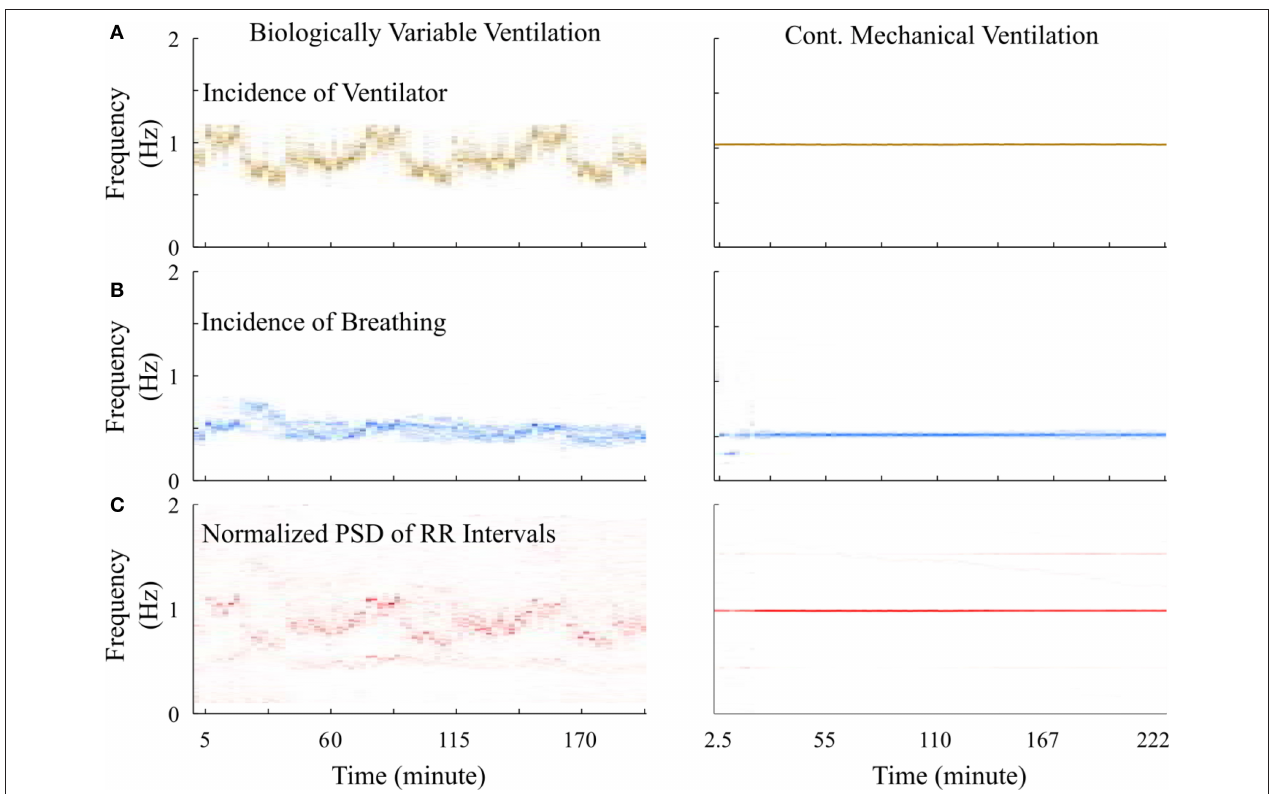
FIGURE 7 | Time-frequency plot of signals measured from a representative BVV and CMV treated rats. (A) Frequency of ventilator were varied during BVV but fixed during CMV. (B) Respiratory frequency of CMV treated rat was constant and was half of the frequency of ventilator. However, the respiratory frequency of the BVV treated rat was relatively independent to the frequency of ventilator. (C) Frequency of RR interval signal of both BVV and CMV treated rat were coupled with the frequency of the ventilator rather than the respiratory frequency. The coupling caused the RR interval signal during BVV to be more